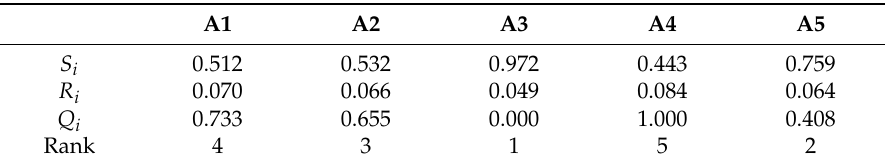
Table 7. The values of S i , R i and Q i for each